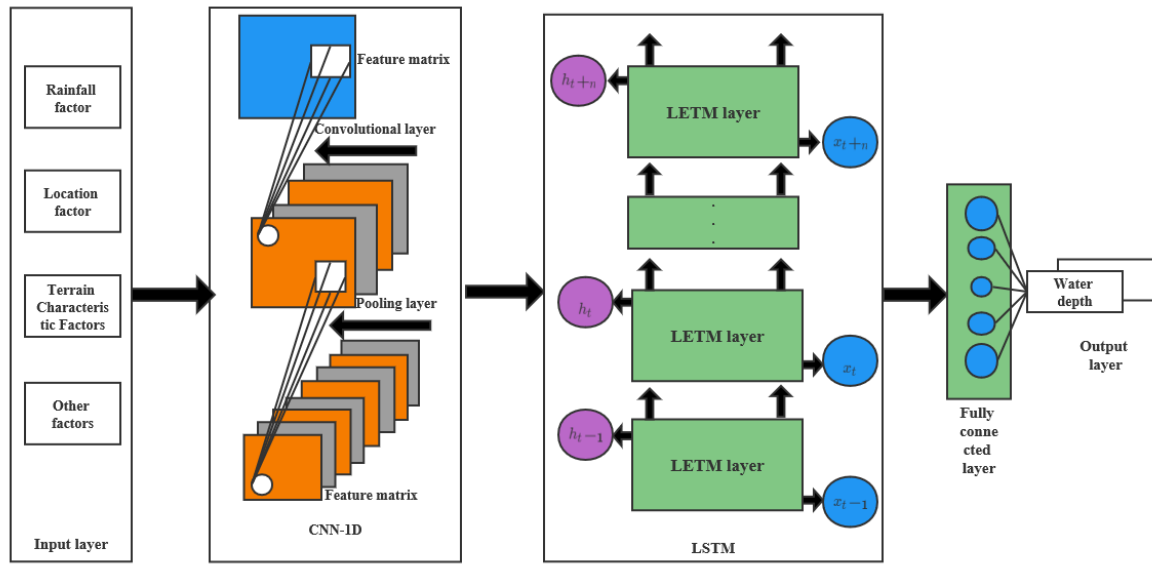
Figure 2. Structure of the neural network combining CNN and LSTM.